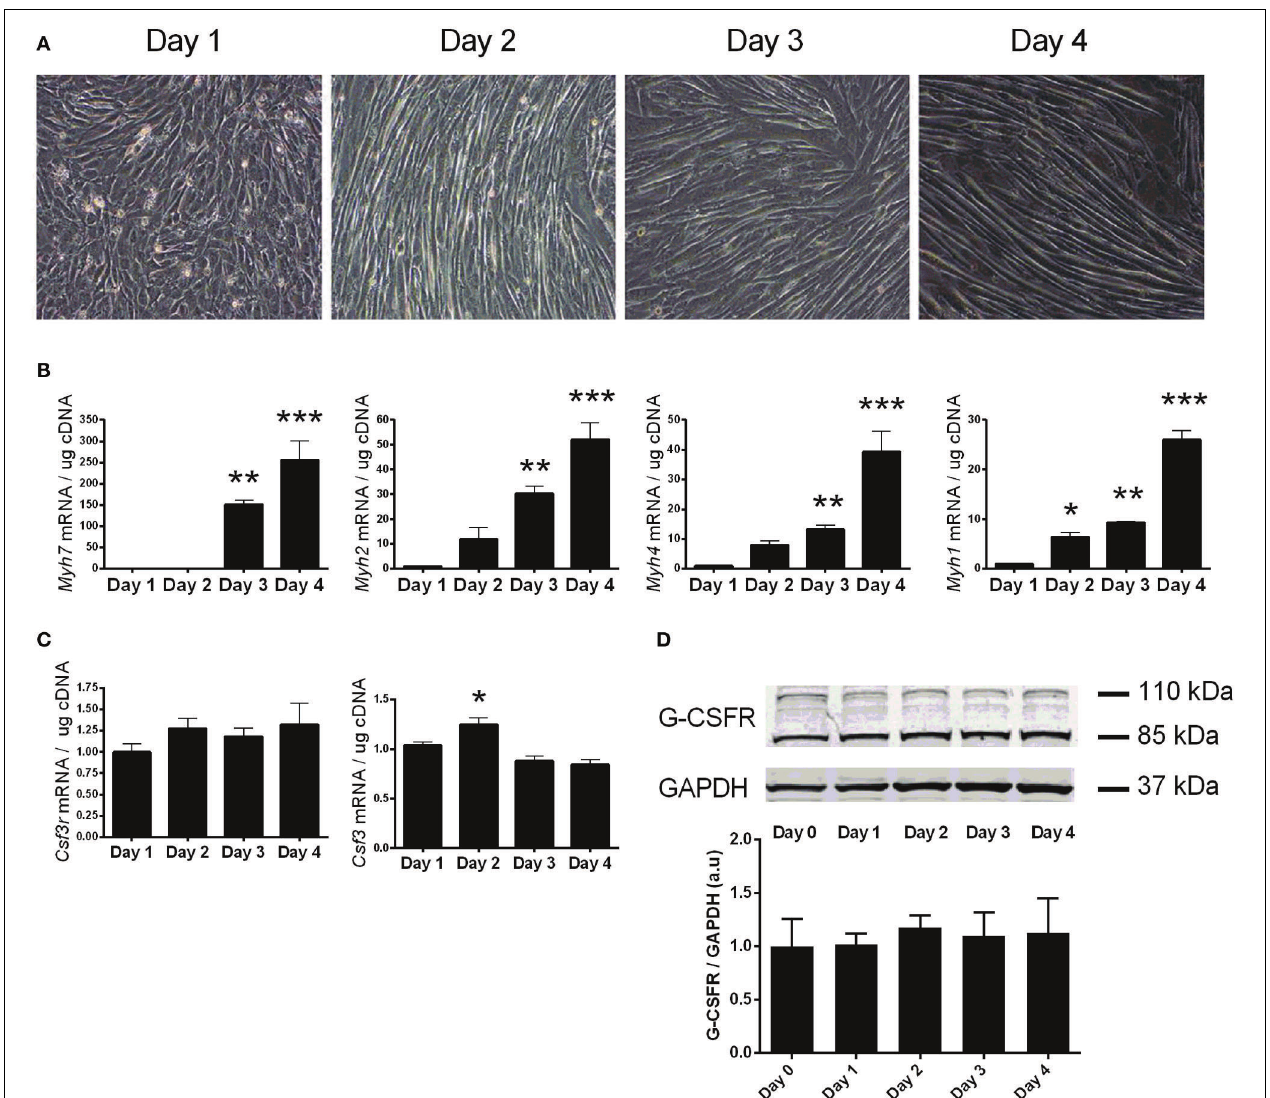
FIGURE 2 | Characterization of G-CSF and G-CSFR during C2C12 myogenesis. (A) Representative images of C2C12 during differentiation. (B) Expression of myosin heavy chain genes (Myh7, 2, 4, 1) during following differentiation of C2C12 cultures. (C) G-CSF ( Csf3) and G-CSFR ( Csf3r) mRNA